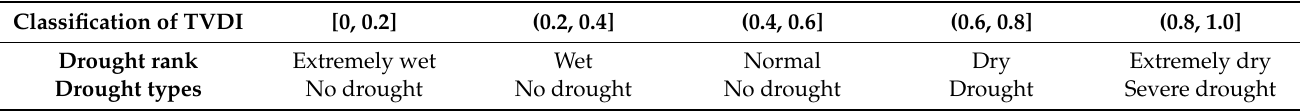
Table 4. TVDI classification criteria of drought in the QTP.